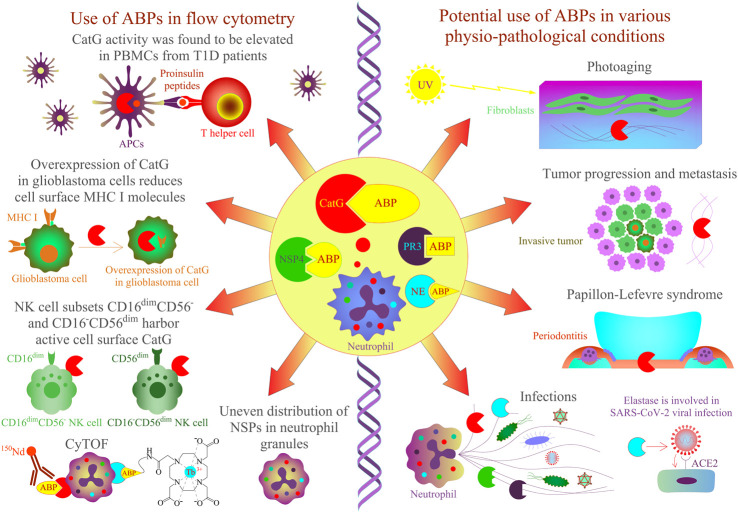
Application of ABPs for NSPs in cells and tissues by flow cytometry approaches. CatG-specific ABPs have been shown to detect protease activity in different biological samples. On the left panel, CatG is involved in proinsulin processing, and its activity was found to be elevated in PBMCs from T1D patients by using an activity-based probe (DAP22c) and T cell activation was assessed by flow cytometry (Zou et al., 2011). NK cell subsets CD16–CD56dim and CD16dimCD56– harbor active cell surface CatG (Penczek et al., 2016) and CD16+CD56–, eosinophils, and neutrophils by using MARS116 in CyTOF analysis (Gartner et al., 2020). The overexpression of CatG in glioblastoma cells was demonstrated to downregulate cell surface MHC I molecules, and CatG activity was verified by using the MARS116 probe (Palesch et al., 2016). NSPs, including CatG, are unevenly located in the granules of neutrophils (Kasperkiewicz et al., 2017), and neutrophil elastase can be detected in various immune cells by CyTOF (Poreba et al., 2020). On the right panel, CatG-specific ABPs could be used to investigate protease activity in various physiopathological conditions such as photoaged human skin, cancer, Papillon–Lefevre syndrome, inflammation, and infection [Hu et al., 2020; Korkmaz et al., 2010; Burster et al., 2020)].